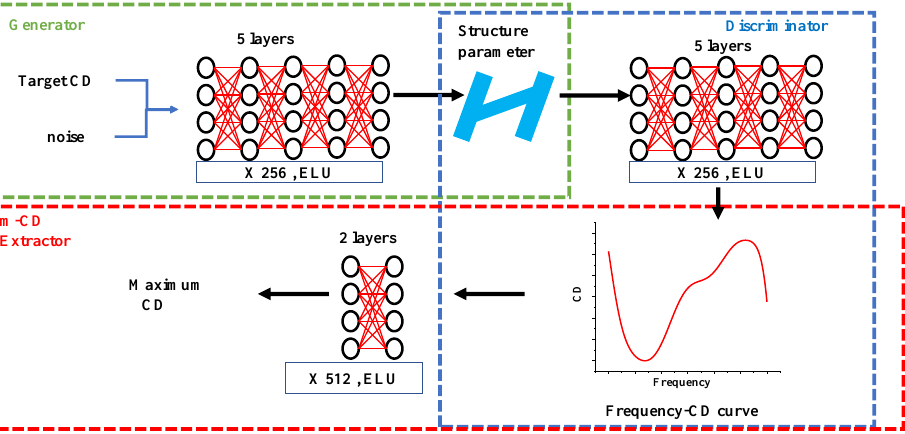
Figure 2. The hidden layers of the generator and discriminator are five layers with 256 nodes in each layer. The hidden layer of the max CD extractor is two layers with 512 nodes in each layer, and they are both composed in a fully connected manner.